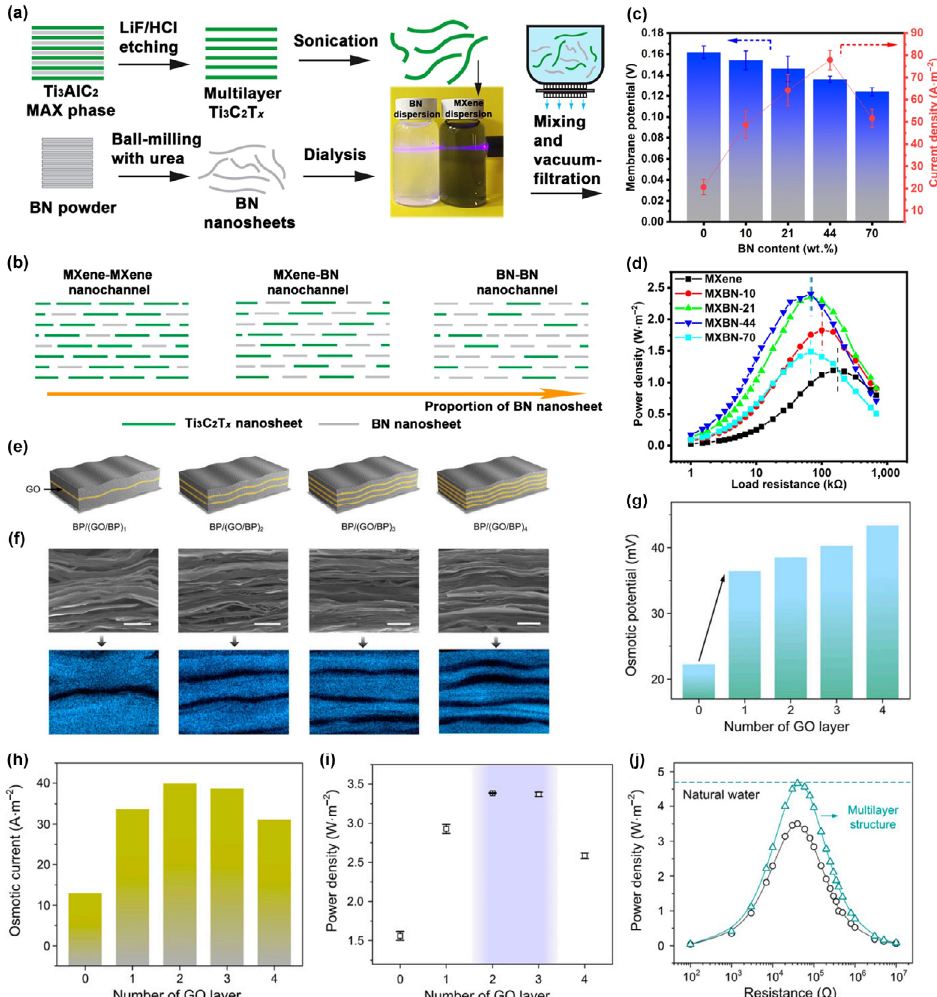
Figure 7 The schematic diagram for the fabrication process of 2D/2D MXene/BN composite membrane (a). Schematic diagram of the three possible configurations of the nanochannels (b). Membrane potential and current density (c), and output power density as a function of BN contents (d). Reproduced with permission from Ref. [90], © American Chemical Society 2021. Schematic illustration of multilayer composite membranes of GO and BP (e). Cross-section SEM and elemental mapping of multilayer membranes with increasing numbers of GO. The blue stripes represent the BP, and the black stripes represent the GO (f). Influence of the number of GO layers on the osmotic potential (g), osmotic current (h), and the overall power density (i). Comparison of the power density of multilayer membrane prepared by sequential filtration (triangle) with the composite membrane prepared via simple mixing of GO and BP (circle) (j). Reproduced with permission from Ref. [91]. © Zhang, Z. et al.